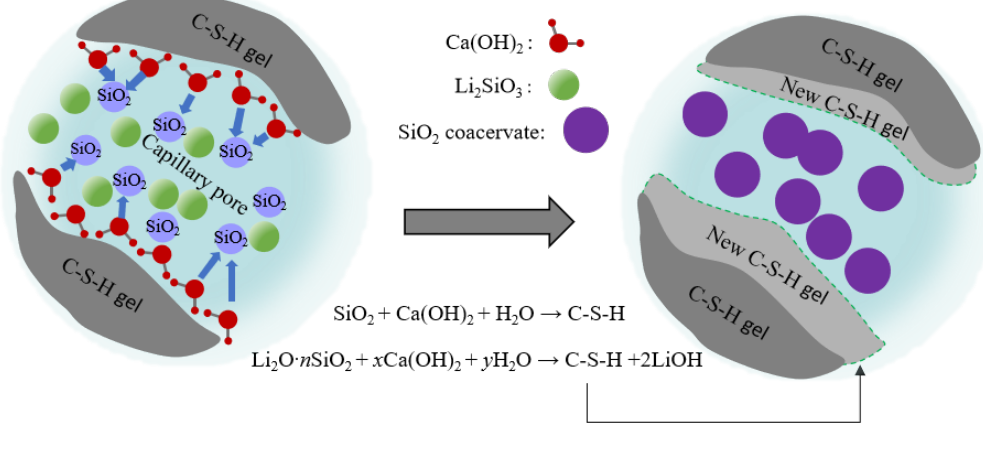
Figure 9. Mechanism of coating and cement-based materials.